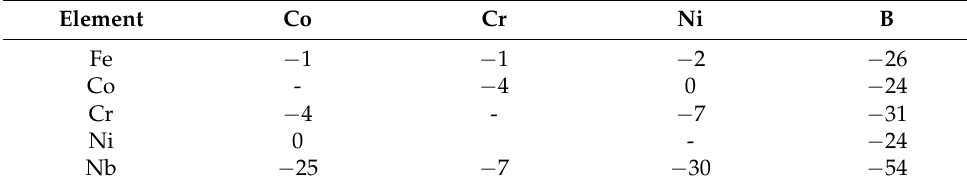
Table 7. Mixing enthalpy of different atom-pair [4]